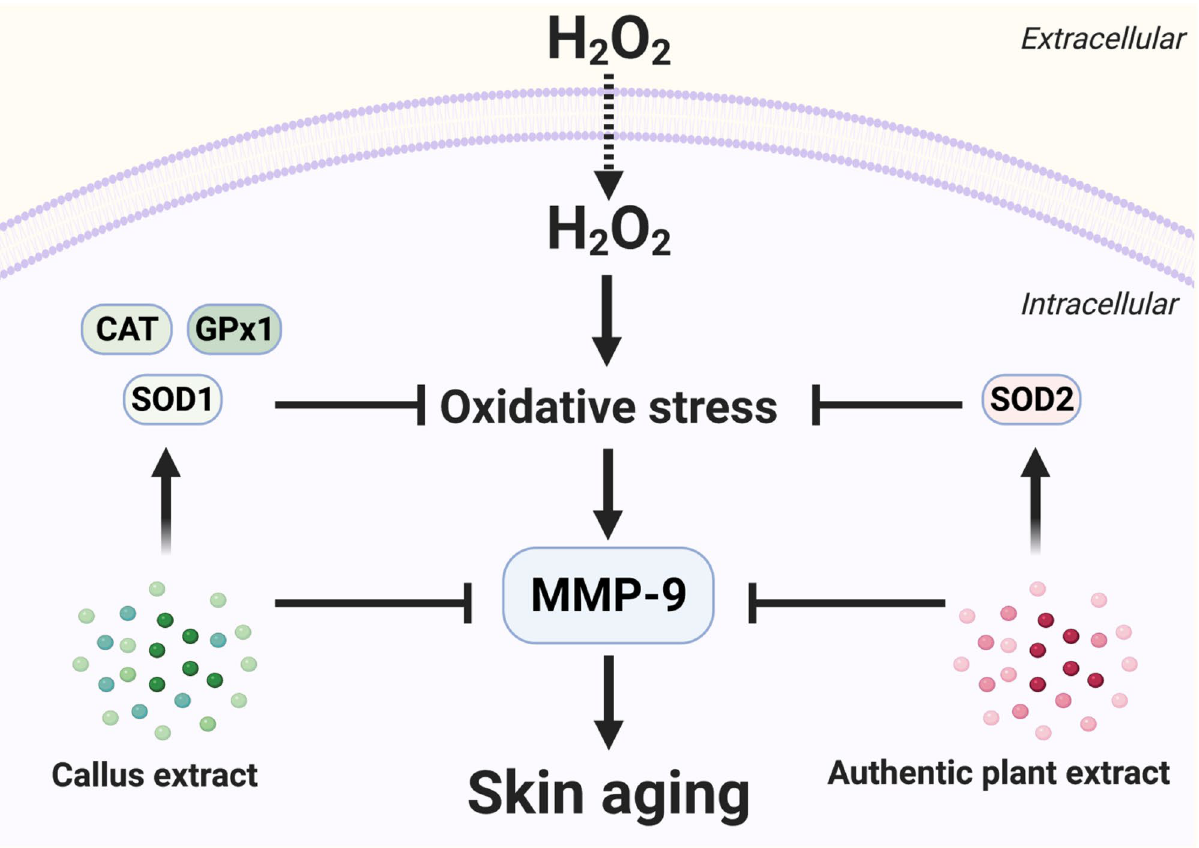
Figure 8. Proposed mechanisms for antioxidant and anti-skin aging activities of Centella extract. Pre-treatment with Centella extracts prevent H 2 O 2 -induced cytotoxicity on dermal fibroblasts by upregulation of